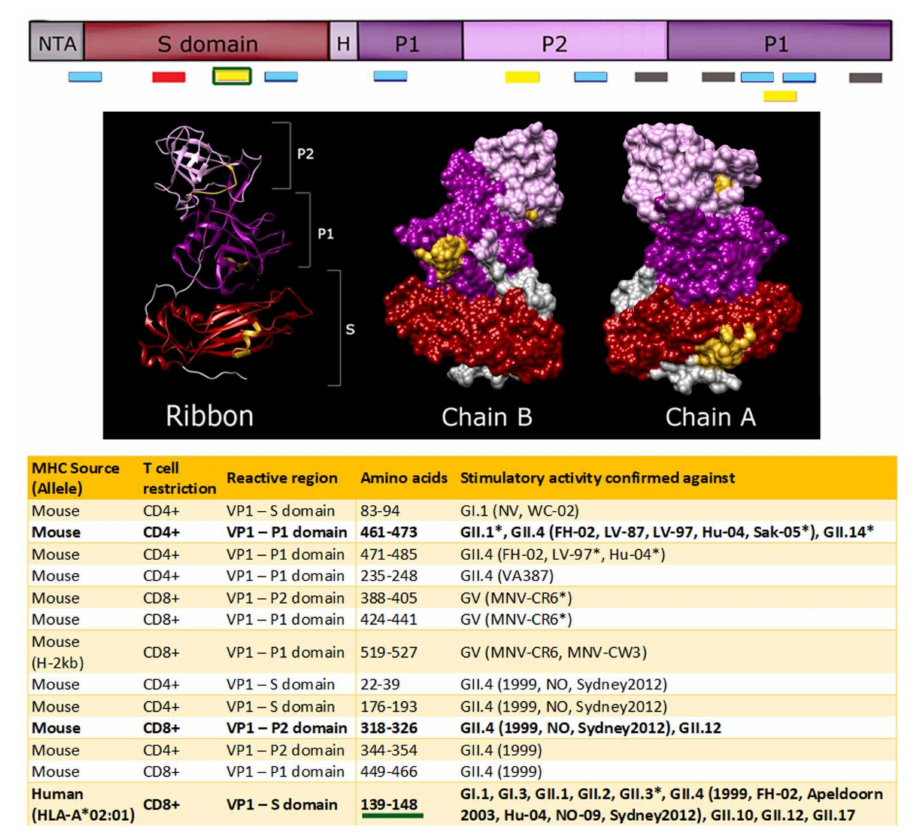
Figure 6. Summary of T cell epitopes mapping to the norovirus VP1 sequence. T cells were isolated from mice and humans with either prior norovirus infection or immunization with VLPs. T cells were stimulated with peptides spanning a norovirus genotype of interest. Reactive epitopes are recorded in the table and illustrated on the linear schematic of VP1. MNV-specific epitopes are shaded grey, GI genotype-specific epitopes are shaded red, and GII genotype-specific epitopes are shaded blue. Three cross-genotype reactive epitopes (bolded in the table), including a human-derived T cell epitope mapping in the S domain (outlined in green), are shaded in gold and modeled on the 3D structure of GI.1 NV VP1. Taken together, the majority of T cell epitopes have been mapped to the S and P1 domains of